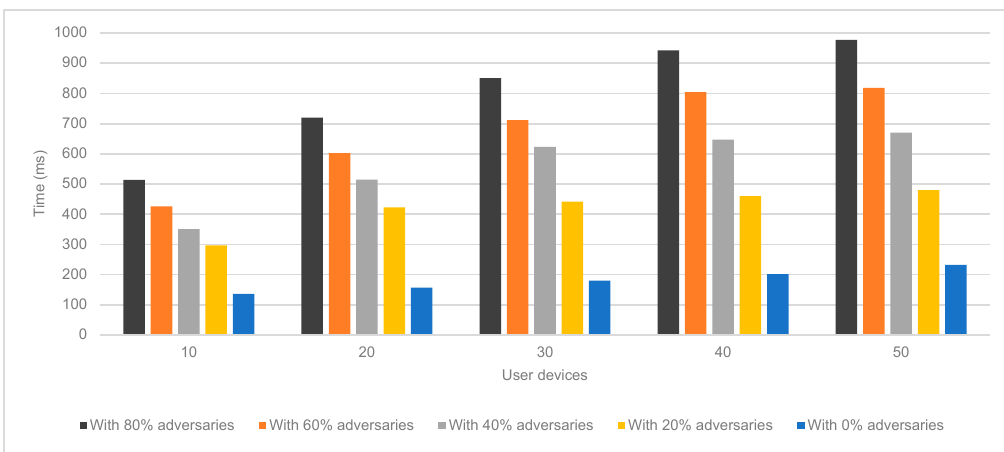
Figure 5. DS message authentication latency evaluation. J. Sens. Actuator Netw. 2022 , 11 , x FOR PEER REVIEW